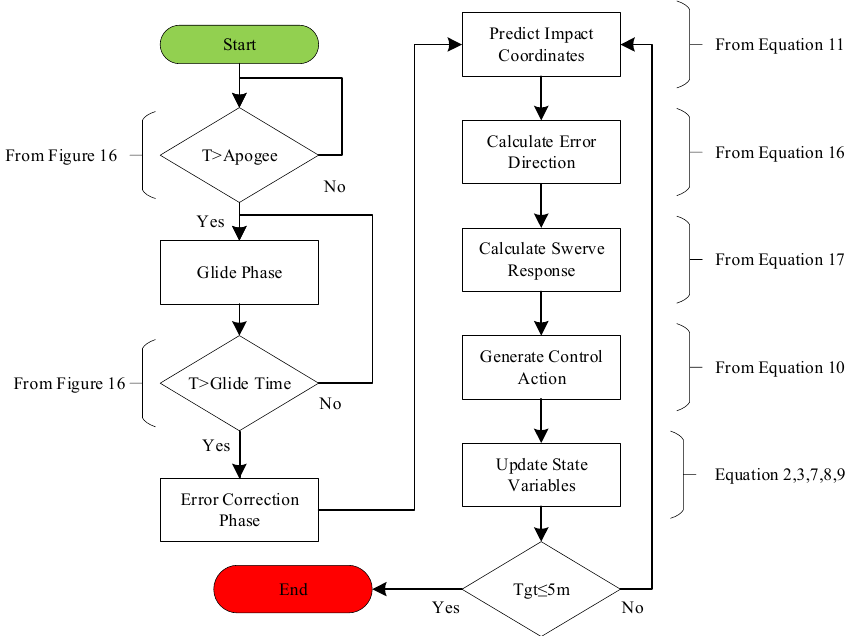
Figure 14. Guidance Algorithm Flow Chart.